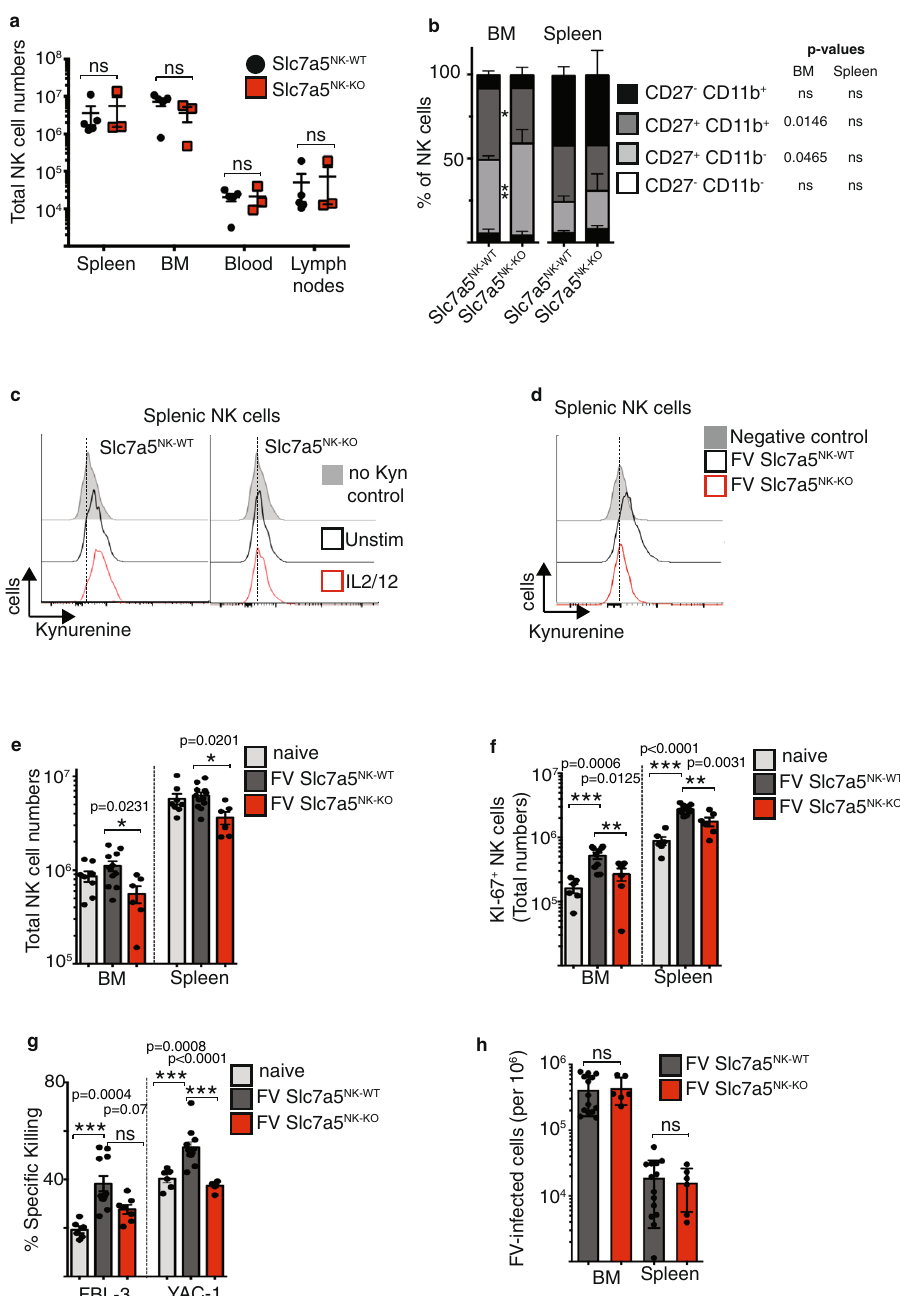
Fig. 5 In fl uence of Slc7a5 deletion in NK cells during acute retrovirus infection. Spleen, bone marrow (BM, tibia and femur of the right hind leg), lymph nodes (axillary, brachial, inguinal) and blood were collected from mice with loxP sites fl anking exon 2 of the Slc7a5 gene crossed with transgenic mice expressing cre recombinase under the control of the NCR1 promoter (Slc7a5 NK-WT and Slc7a5 NK-KO mice). Single-cell suspensions were counted, stained for NK cell markers (CD3 − CD19 − NK1.1 + NKp46 + ) and measured by fl ow cytometry ( a ). Cell numbers in the blood were calculated per ml of blood. A minimum of three mice from two independent experiments were used and analysed by Mann – Whitney test. Data are presented as mean values ± SEM. Frequencies of CD27 and CD11b NK cell subsets of Slc7a5 NK-WT and Slc7a5 NK-KO mice are displayed in b for bone marrow and spleen. Data are presented as mean values ± SEM. NK cell kynurenine (kyn) uptake of unstimulated or IL-2/12-stimulated NK cells is displayed in c . Slc7a5 NK-WT and Slc7a5 NK-KO were infected with FV and at 7 dpi, the spleen and bone marrow of FV-infected Slc7a5 NK-WT , Slc7a5 NK-KO , or naive mice were harvested. A representative histogram from splenic NK cells (CD3 − CD49b + NK1.1 + ) from Slc7a5NK-WT and Slc7a5NK-KO mice is shown in d . Experiments were repeated independently twice with similar results. The absolute cell numbers of NK cells ( e ) and their proliferation ( f ) are displayed as bar graphs ± SEM. YAC-1 cells (right-hand side) or FV-induced tumour cells (FBL-3 cells, left-hand side) were stained with Tag-it-violet and co-incubated with isolated, splenic NK cells for 18 h ( g ). Viral loads were analysed by an IC assay in Slc7a5 NK-WT and Slc7a5 NK-KO mice ( h ). Data are presented as mean values ± SEM ( g , h ). A minimum of six mice per group from two independent experiments was used ( e – h ) and analysed by ordinary one-way ANOVA ( b , e , f ), unpaired t -test ( h ) or Kruskal – Wallis test ( g ). Signi fi cances are indicated as follows: ** p < 0.01, *** p < 0.001. Source data are provided as a Source Data fi le. BCH 2-Amino-2- norbornanecarboxylic acid, ns not signi fi